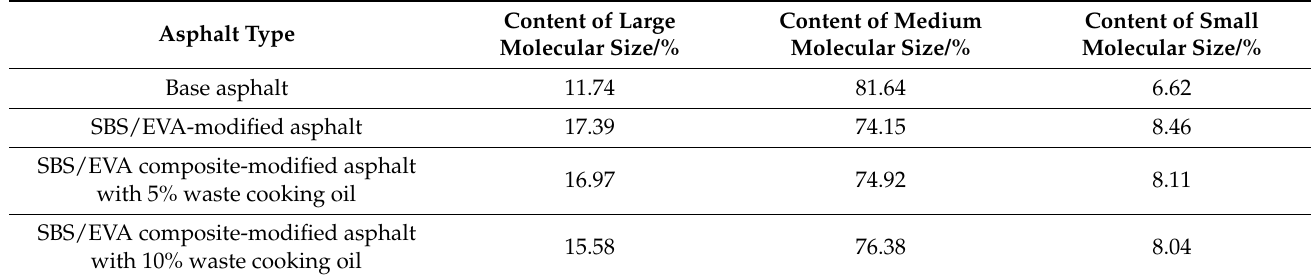
Table 1. Analysis on chemical composition based on gel permeation chromatography [23].